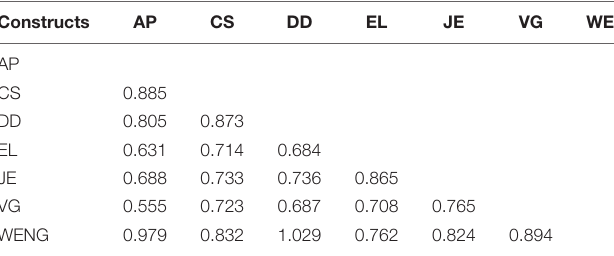
TABLE 3 | Summary of results of the HTMT ratio of correlations.